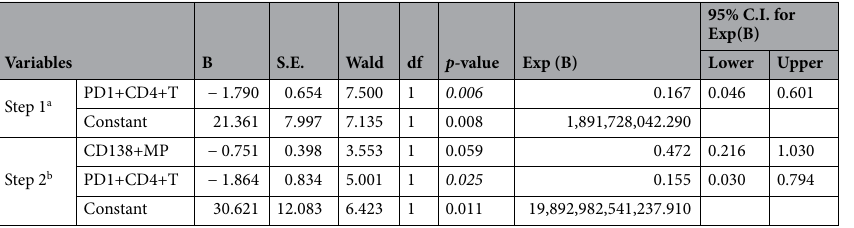
Table 9. Variables in the Equation of logistic regression (Ln (dependent = CR) = 30.621 – 0.751 * 1 – 1.864 * 2). a Variable(s) entered on step 1: PD1+CD4+T cells, b Variable(s) entered on step 2: CD138+MP, Exp(B); odds ratio, CI; confidence interval, df; degrees of freedom, p < 0.05.